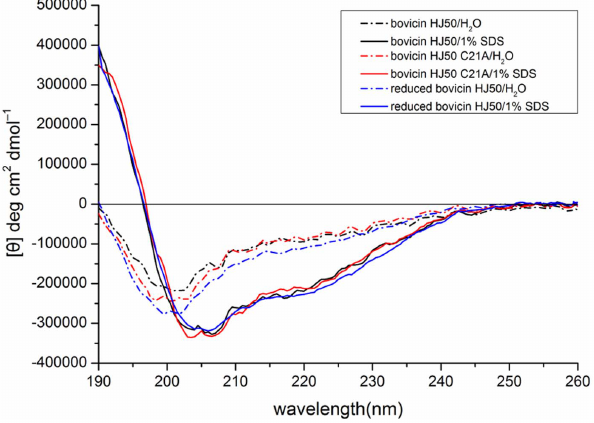
Figure 8. Comparison of hydrophobicity of bovicin HJ50 and its mutants by ANS binding analysis. Bovicin HJ50 (black curve), its reduced form (blue) and mutant C21A (red). H 2 O was used as negative control (green).